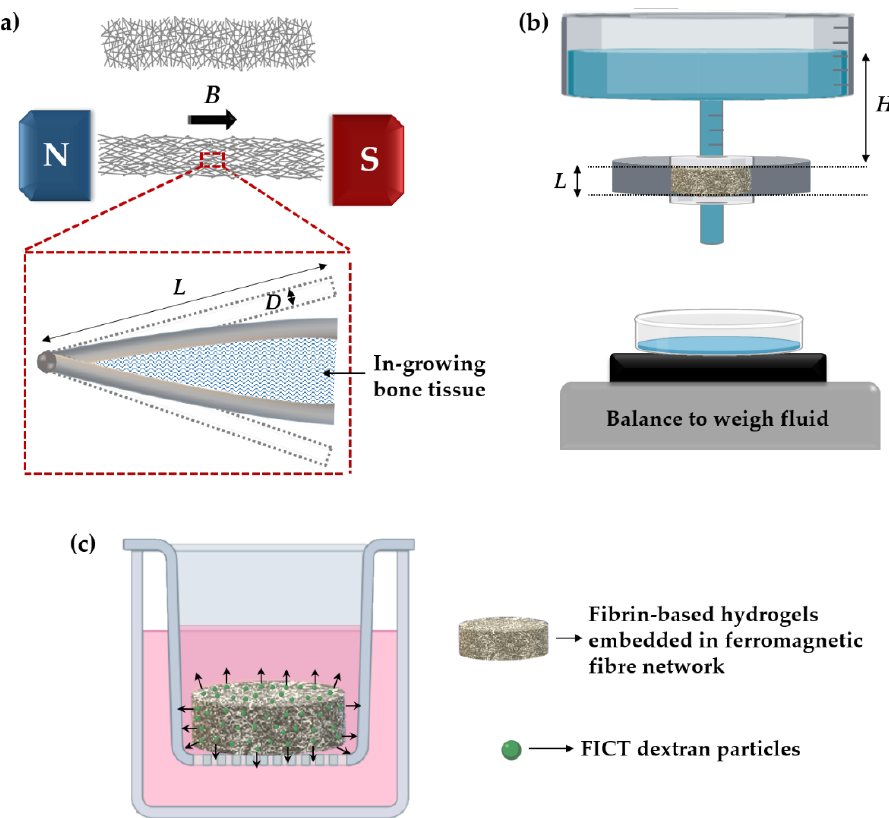
Figure 1. ( a ) Schematic representations of the elastic deformation of a fibre network under a magnetic field B . Also shown is the deflection of a bonded pair of fibres deforming in-growing bone tissue; Schematic of the set-up employed for measuring: ( b ) specific permeability; ( c ) FICT-dextran diffusion of the scaffolds.